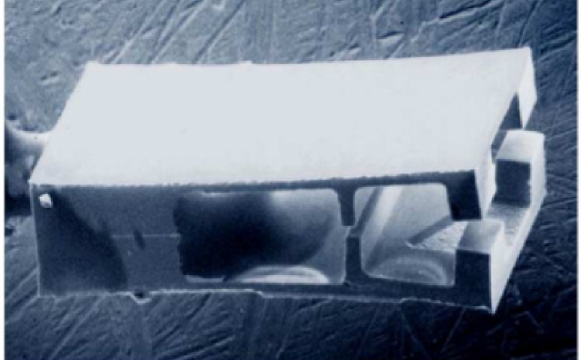
Figure 2. TiNi/Si microgripper with cantilever structure. Reproduced with permission from Ref. [16].